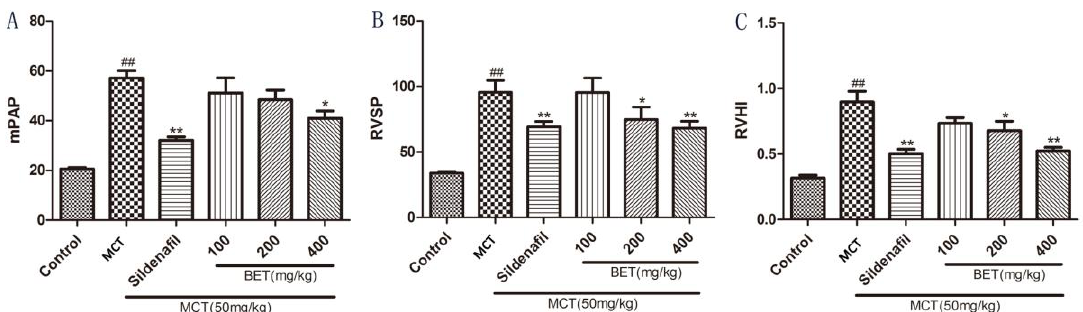
Figure 1. Effects of betaine on monocrotaline-induced pulmonary hypertension. ( A ) Effect of betaine (BET) on the mean pulmonary arterial pressure (mPAP). ( B ) Effect of BET on the right ventricular systolic pressure (RVSP). ( C ) Effect of BET on the right ventricular hypertrophy index (RVHI). Data are expressed as mean ± standard error of the mean ( n = 6). ## p < 0.01 vs. control group, * p < 0.05, ** p < 0.01 vs. MCT group. MCT: monocrotaline-induced group.